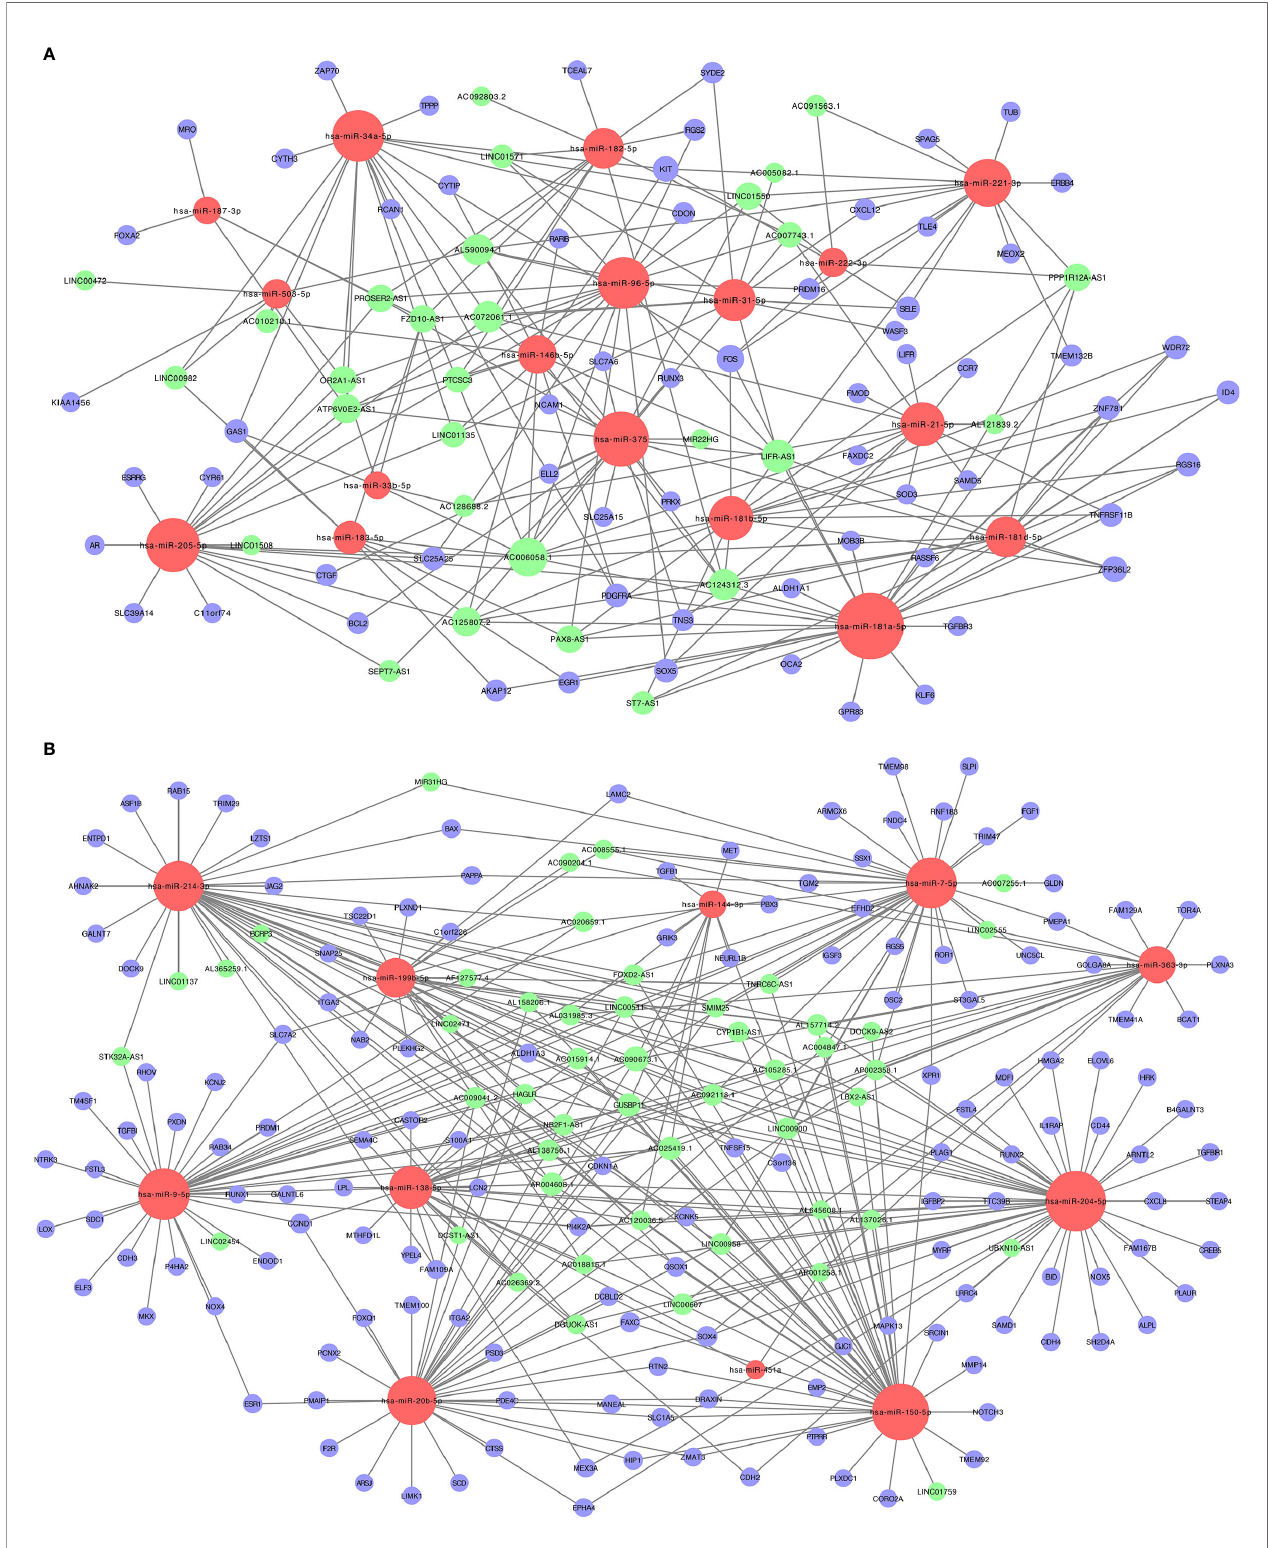
FIGURE 2 | The lncRNA-miRNA-mRNA ceRNA (competitive endogenous RNA) networks. (A) Downregulated lncRNAs (green) and mRNAs (purple) and upregulated miRNAs (red); (B) upregulated lncRNAs (green) and mRNAs (purple) and downregulated miRNAs